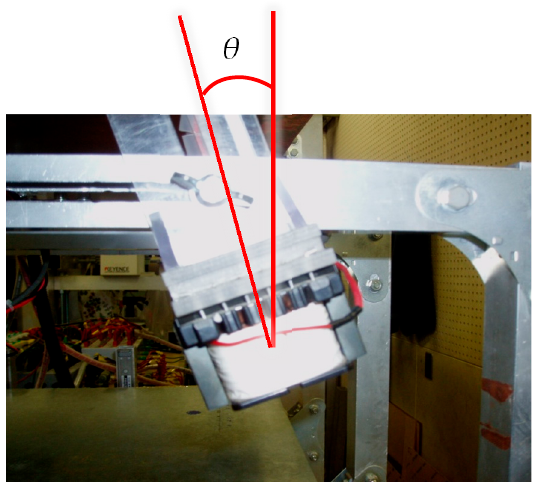
Figure 4. Electromagnet angle.